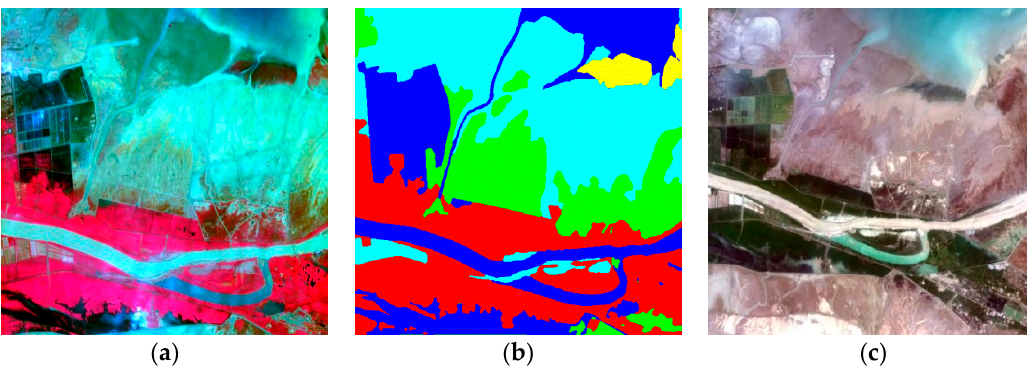
Table 1. Compact high resolution imaging spectrometer (CHRIS) product description.